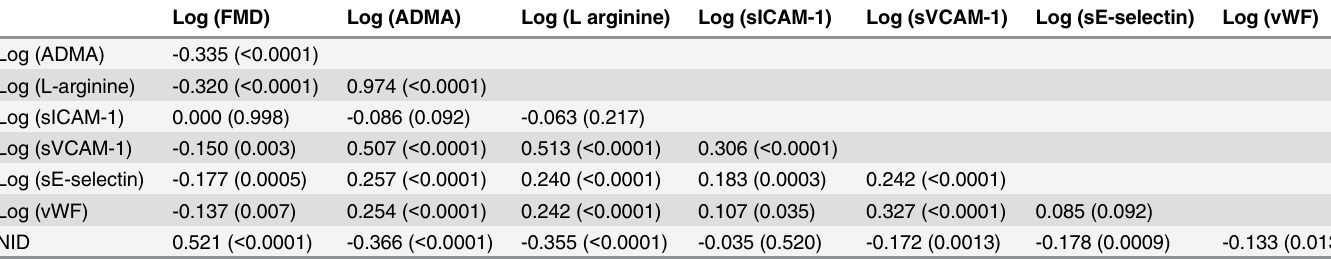
Table 4. Pearson Correlation Coefficients ( P values) Among Endothelial Function